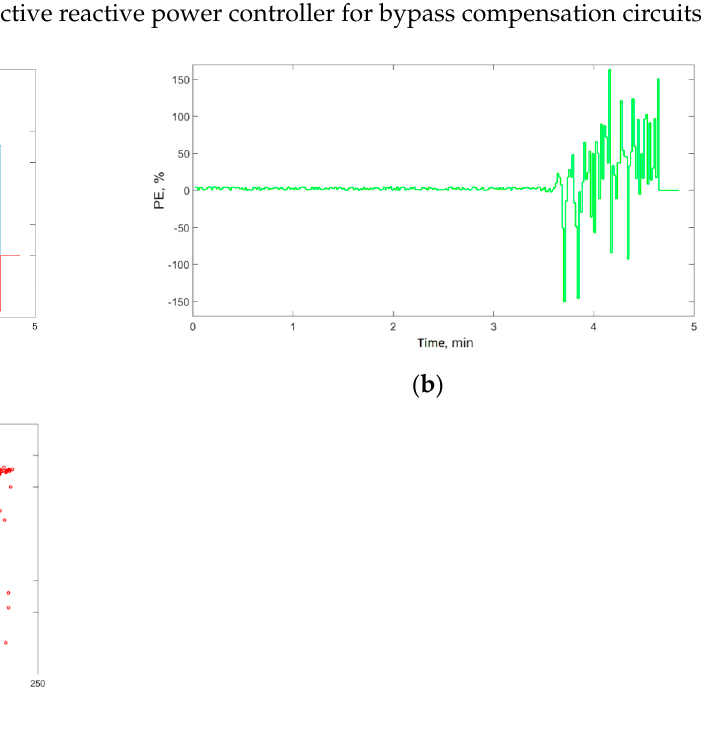
Figure 8. Simulation results for individual evaluation criteria: ( a )—criterion I, ( b )—criterion III, ( c )— criterion II, ( d )—criterion IV.